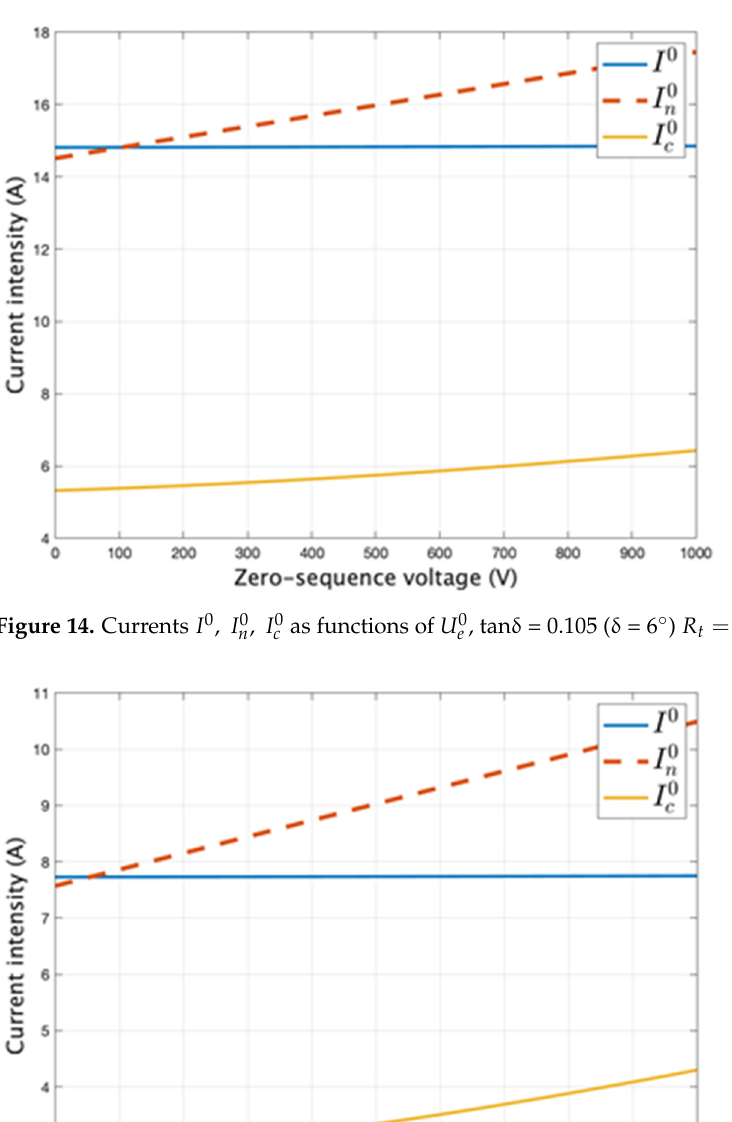
0 0 δ = 0.105 ( δ = 6 ◦ ) R t = 1000 Ω n , I c as functions of U e , tan